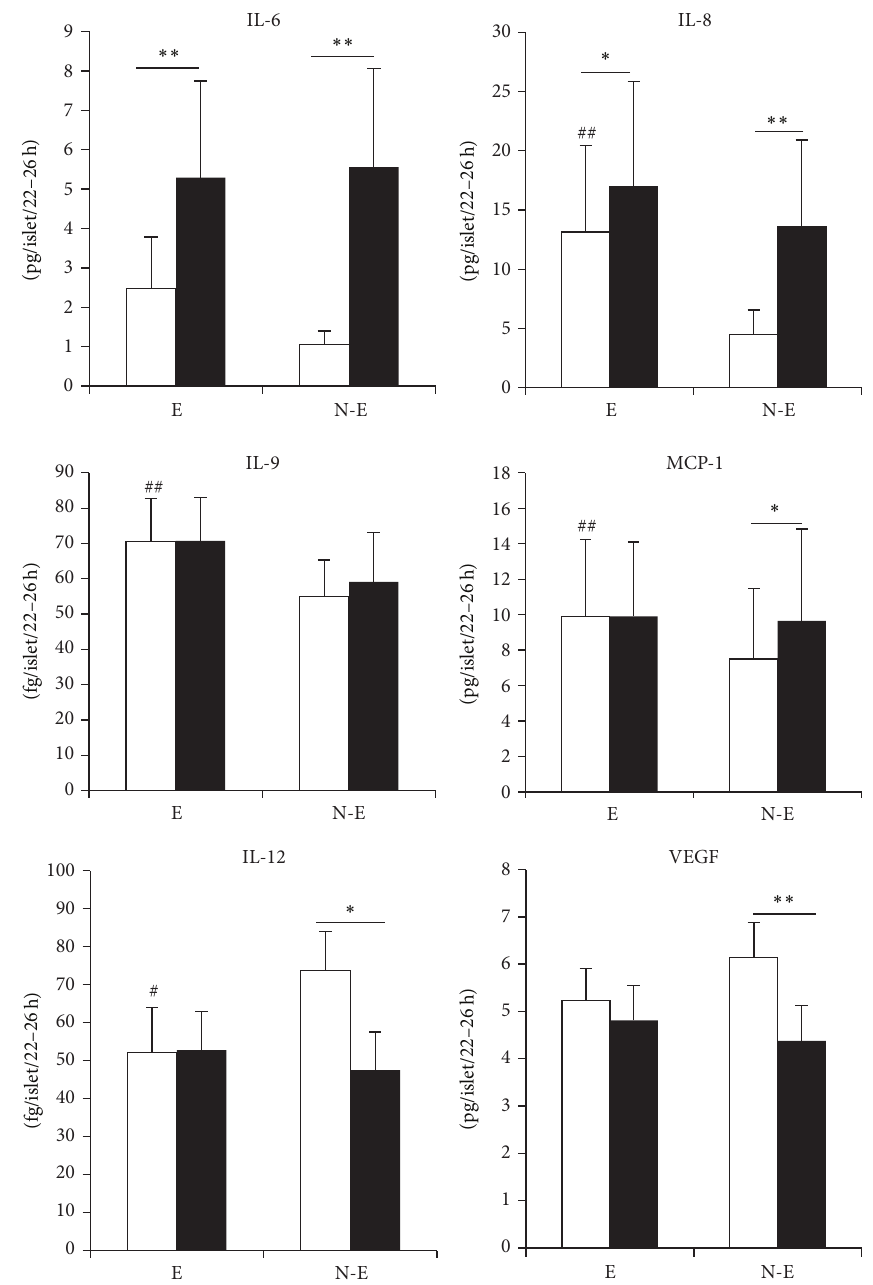
Figure 3: Secreted mediators from encapsulated (E) and nonencapsulated (N-E) islets following culture in continuous normoxia (open bars) and transient hypoxia (filled bars). ∗ 𝑃 < 0.03 and ∗∗ 𝑃 < 0.001 for the effect of hypoxia, # 𝑃 < 0.05 and ## 𝑃 < 0.003 for the effect of encapsulation during normoxia. Data are mean ± SEM of 13 separate experiments (one sample per condition), one-five experiments per donor (five